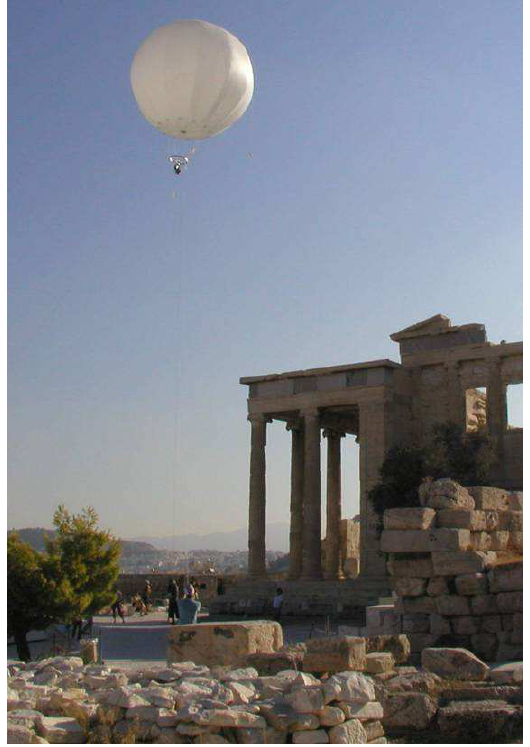
Figure 1: Balloon-photogrammetry for the Acropolis Athens